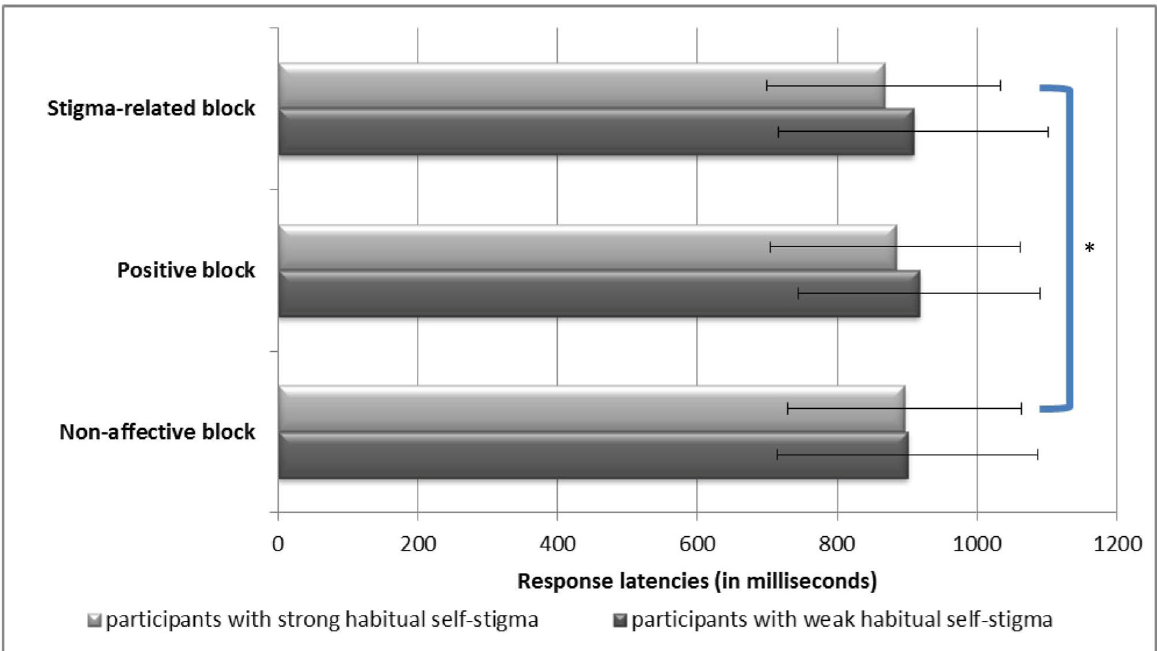
Fig 1. Participants ’ performance on the emotional Stroop task. Mean response latencies in the stigma-related, positive, and non-affective blocks. An asterisk indicates a significant